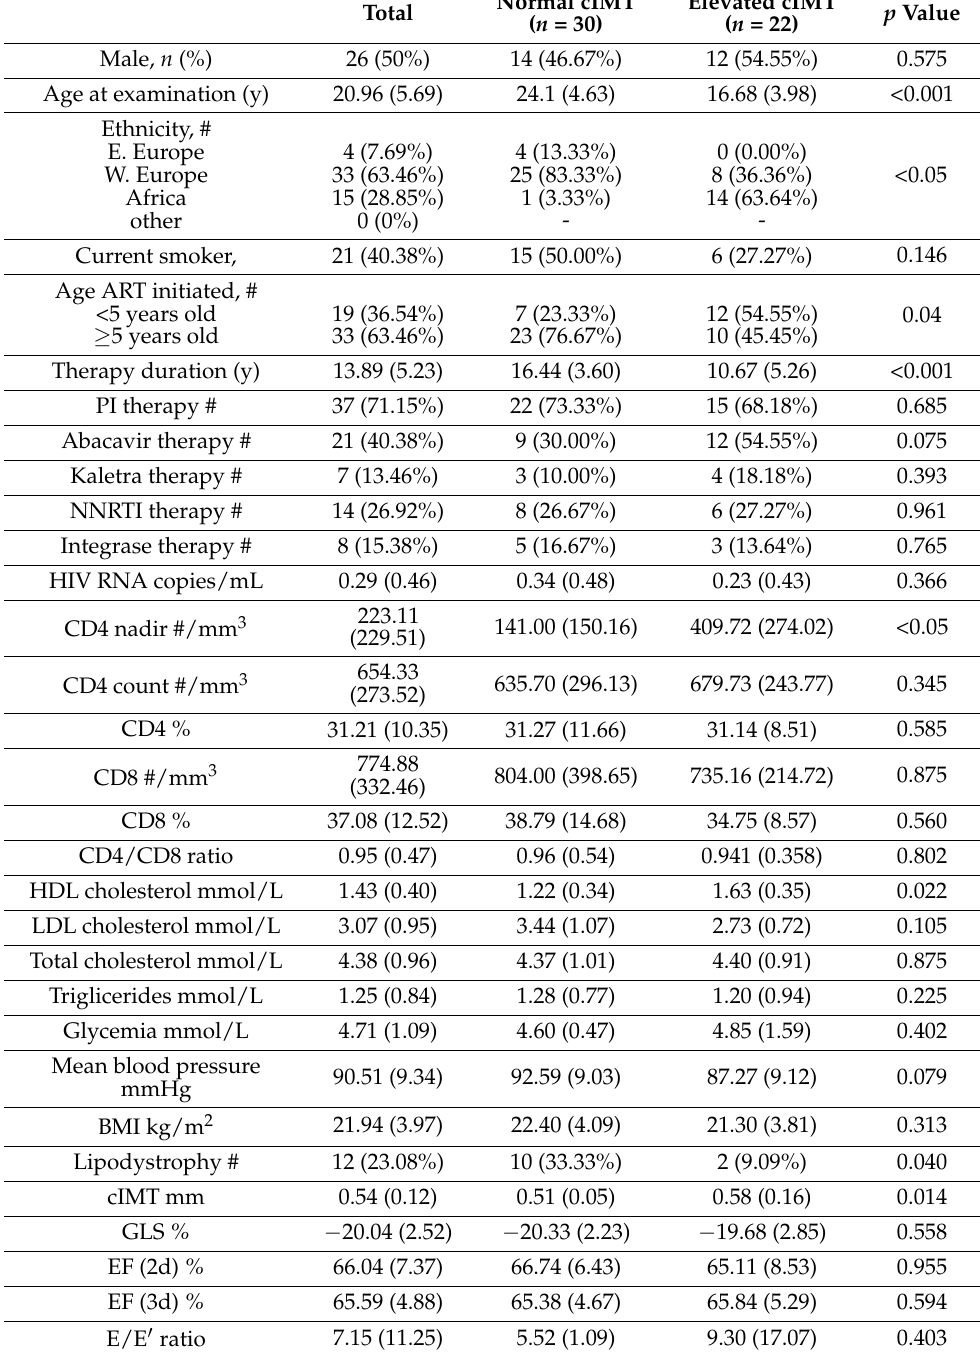
Table 3. Univariate statistical analysis results. Primary outcome: prevalence of cIMT > 2 SD over non-normalized mean of 22 (42.31%). Secondary outcomes: prevalence of GLS 2SD over mean of 10 (19.23%) and prevalence of EF3D 2SD over mean of 15 (28.85%). Exploratory: linear regression of cIMT value with time on ART, key agent (separate models for PI, Abacavir, Kaletra, NNRTI and integrase), current smoker (yes/no), RNA copies, CD4 nadir and total cholesterol. Data are shown as number (#), (%) or mean